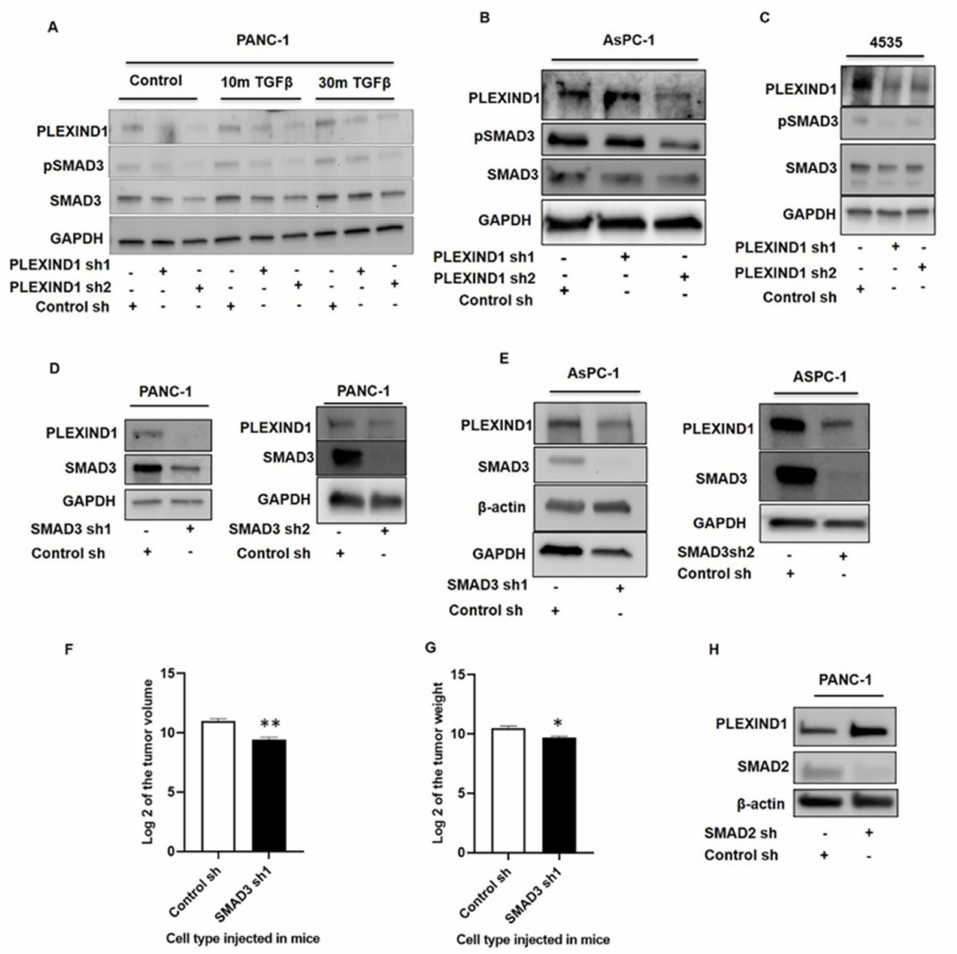
Figure 4. PLEXIND1 modulates SMAD3 signaling and, eventually, PDAC growth. ( A ): Western blot analysis showing levels of phosphorylated and total SMAD3 in PANC-1 cells with reduced PLEXIND1 expression at basal levels and upon TGF β induction. ( B , C ): Western blot analysis showing levels of phosphorylated and total SMAD3 in AsPC-1 and 4535 cell lines. ( D , E ): Western blot analysis showing PLEXIND1 expression in PANC-1 andAsPC-1 cells with reduced SMAD3 levels. ( F , G ): Log2 values of the tumor volume and weight from orthotropic mice models implanted with PANC-1 cells with SMAD3 knockdown. ( H ): Western blot analysis showing PLEXIND1 expression in PANC-1 cells with SMAD2 knockdown. Error bars represent standard error of the mean. Statistical significance * p < 0.05 vs. control, ** p < 0.01 vs.